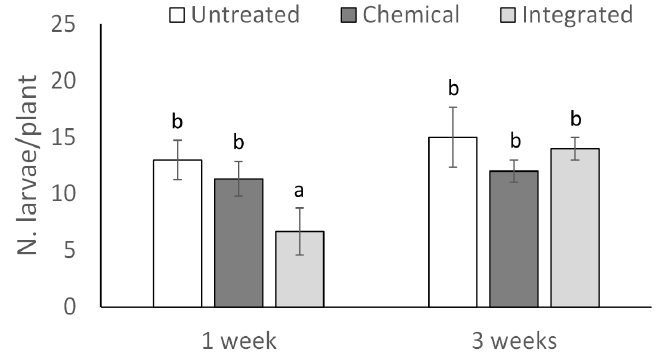
Figure 6. Density (mean ± SD) of O. nubilalis larvae assessed on treated (chemical and integrated) and untreated plots, one and three weeks after applications of Btk (BioBit) in the integrated plots. Different letters above bars indicate significant differences among means (ANOVA Mixed Proc., p < 0.05).